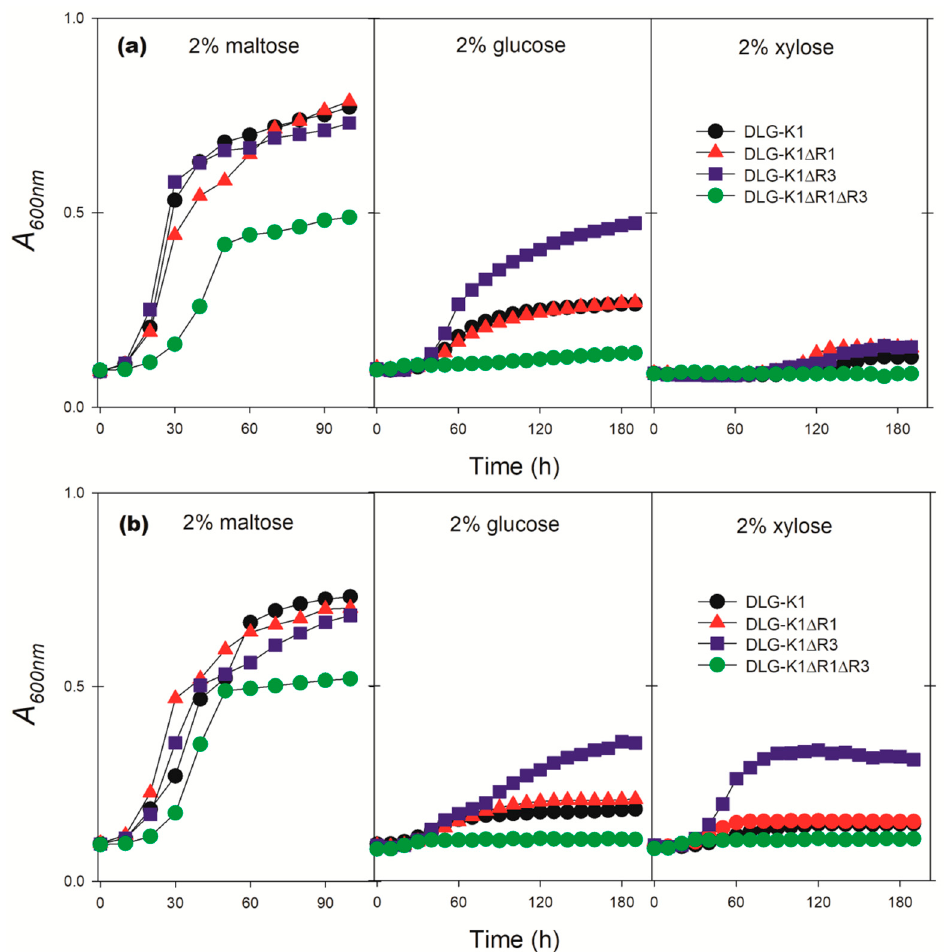
Figure 6. Growth under microaerobic conditions of the indicated hxt -null strains containing the pPGK- SpXUT1 ( a ) or pGPD- SaXUT1 ( b ) plasmids on O-YNB medium containing 2% of the indicated carbon sources in a microplate reader at 30 °C.